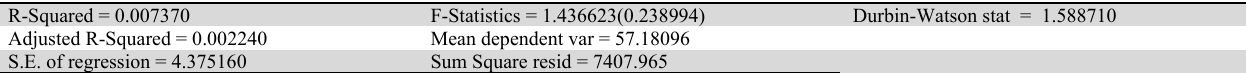
The results of F